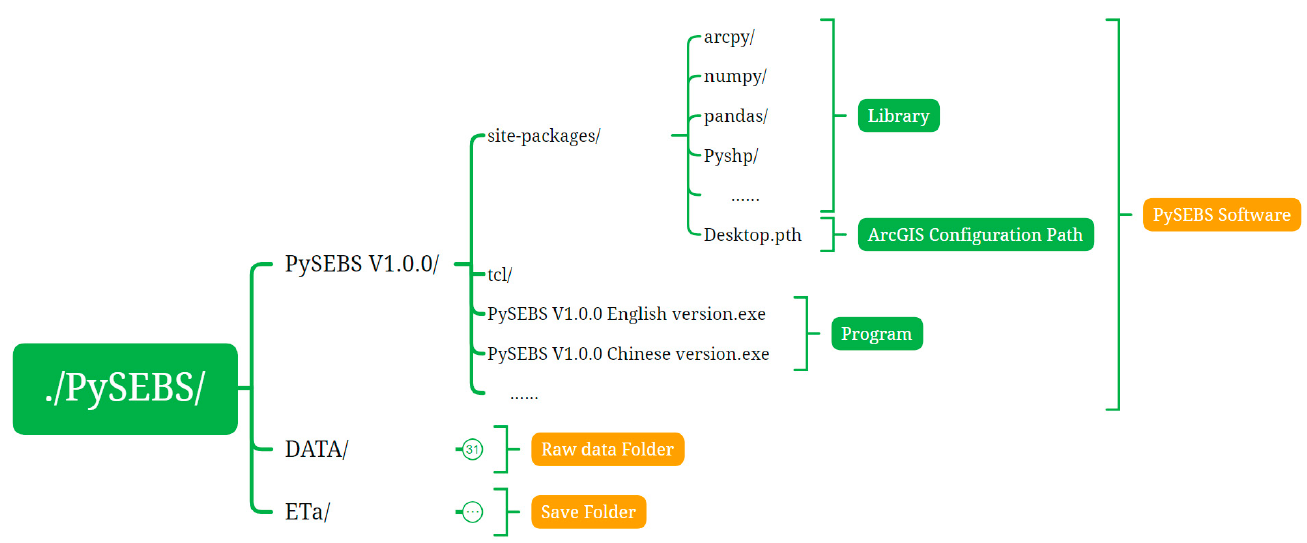
Figure 1. Schematic diagram of the PySEBS software file structure.